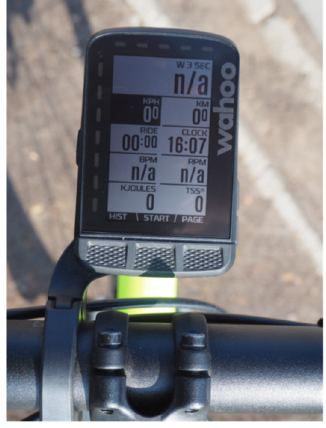
Figure 2. Cycling computer used for testing.